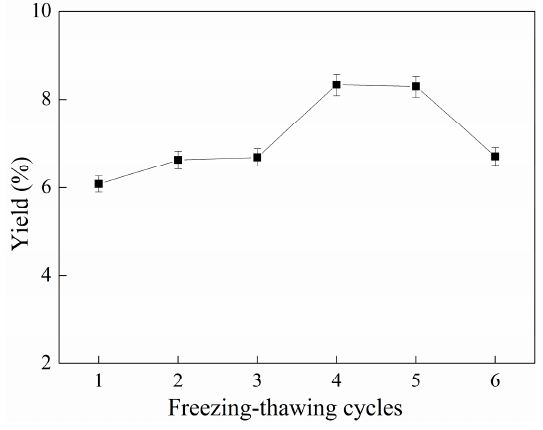
Figure 4. Relationship between freezing-thawing cycles and yield of C-PC. Error bars indicate standard deviations of the means ( n = 3).